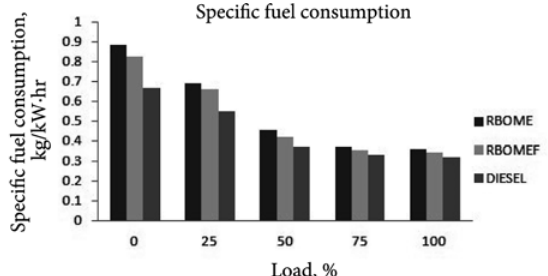
Fig. 6. Specific fuel consumption with respect to load